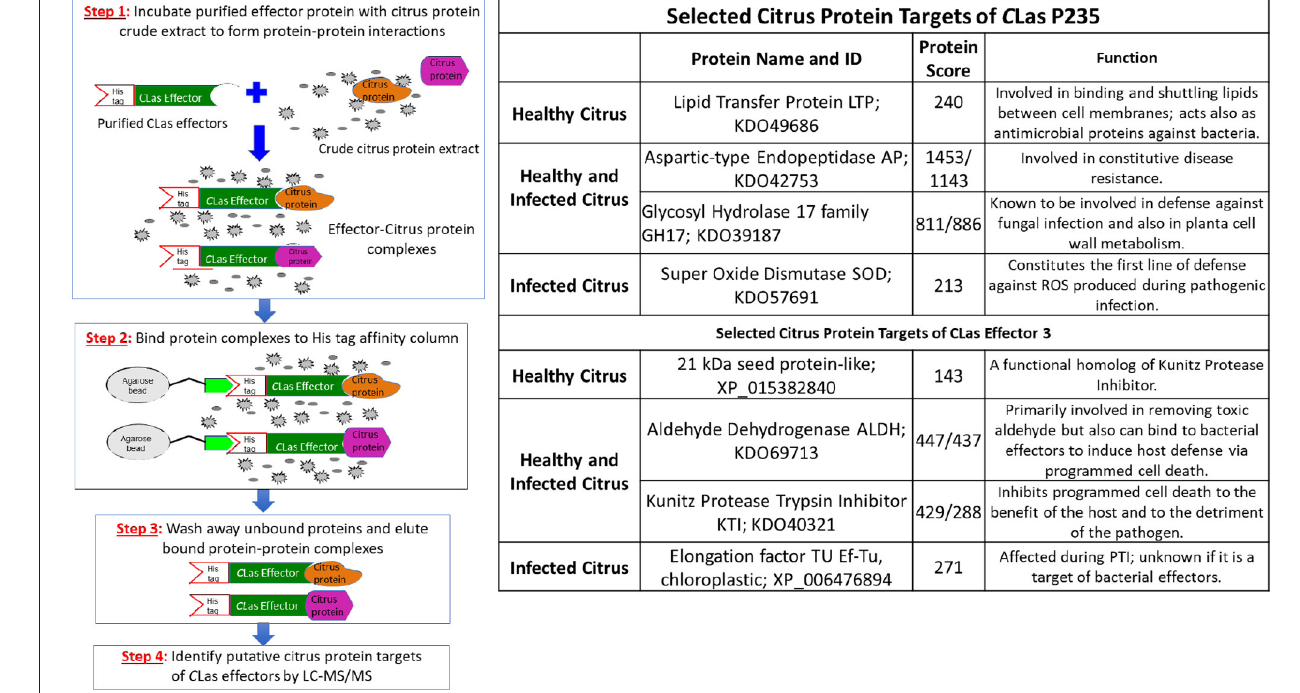
FIGURE 1 | Identification of citrus target proteins of the C Las effectors. (Left) Outlines of the experimental steps. Step 1. C Las effectors were overexpressed in E. coli with His 6 tag. Purified His 6 -tagged effectors (colored green) were incubated with protein extracts from healthy and infected Hamlin citrus. Specific citrus target protein (colored orange and magenta) bound to the C Las effectors. Step 2. Effector-target complexes were TALON on Agarose beads and non-target citrus proteins were washed away. Step 3. The specific effector-target complexes were eluted. Step 4. The citrus target proteins from the eluted complexes were identified by LC–MS/MS. (Right) Selected citrus protein targets of the C Las effectors, LasP 235 and Effector 3. The citrus targets were chosen on the basis of their high protein scores. The target proteins were selected both from healthy and C Las-infected protein extracts. GenBank sequence IDs and putative functions (based on the literature data) of the citrus targets are